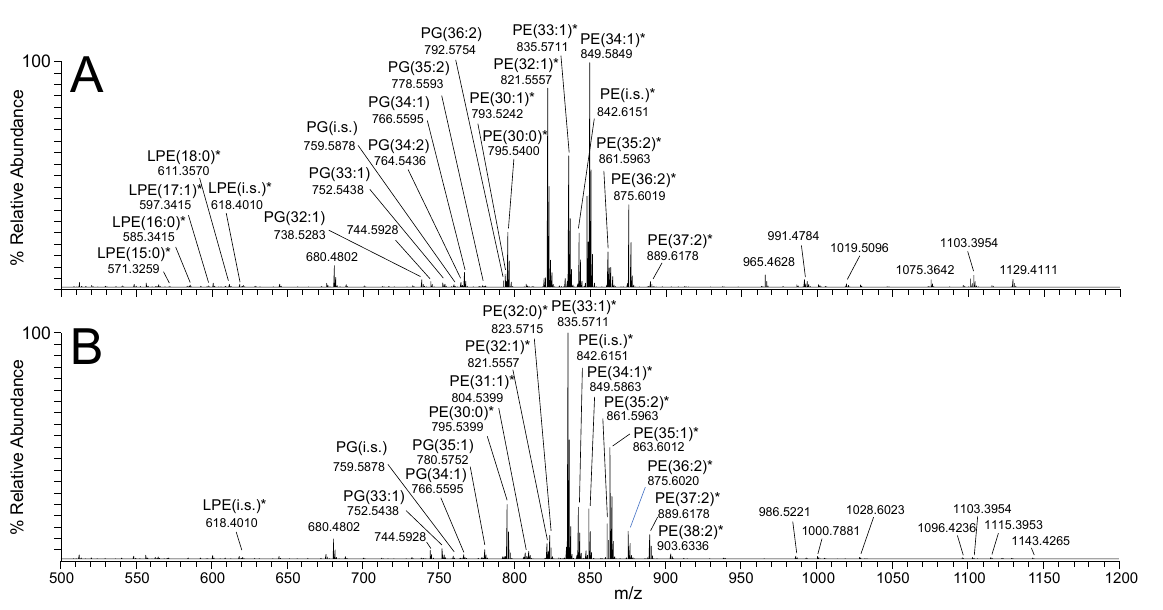
Figure 1. Positive ionisation mode (+ve) ‘shotgun’ nESI-UHRAMS spectra of crude derivatised lipid extracts from E. coli grown under ( A ) EGP (O.D. = 1) and ( B ) SGP (O.D. = 4.6) conditions. * indicates a derivatised PE lipid.